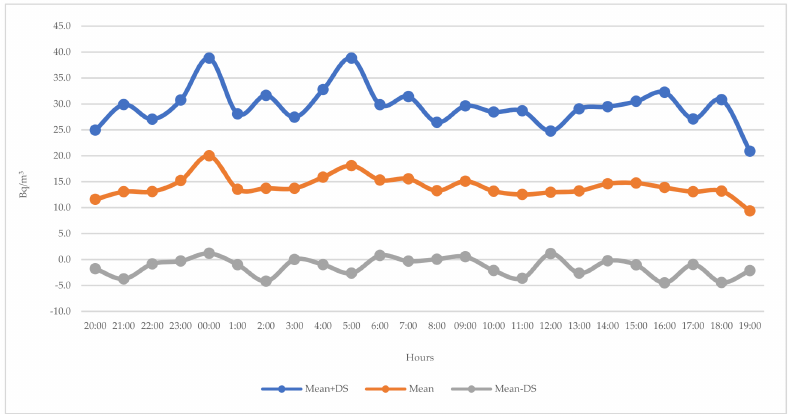
Figure 2. Average values and standard deviations of radon in the 24 inspections—a 24-h